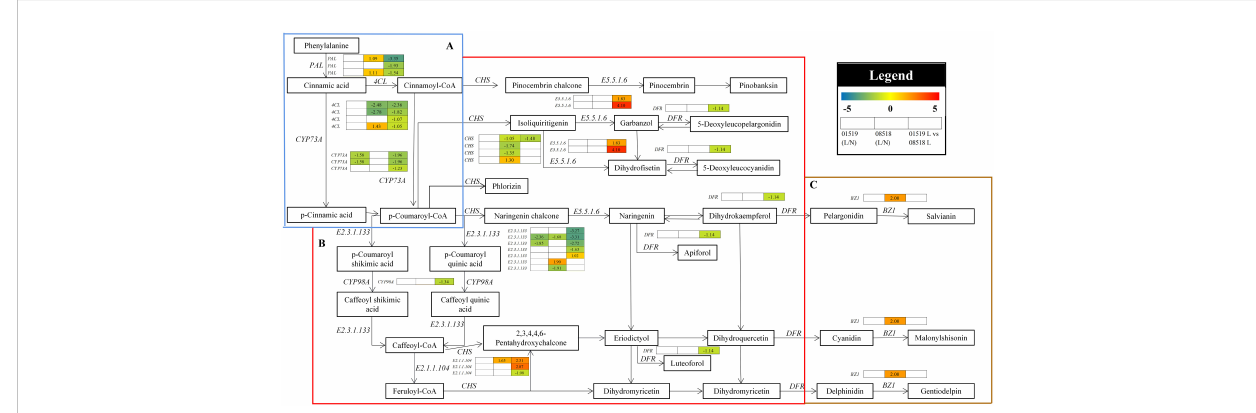
FIGURE 6 The pathways of phenylpropanoid biosynthesis (A) , fl avonoid biosynthesis (B) and anthocyanin biosynthesis (C) enriched in the KEGG analysis. Log2 (fold-changes) of the comparisons are shown by the numbers in the gray rectangles. The comparisons show that each of the genes in the picture is signi fi cantly differentially